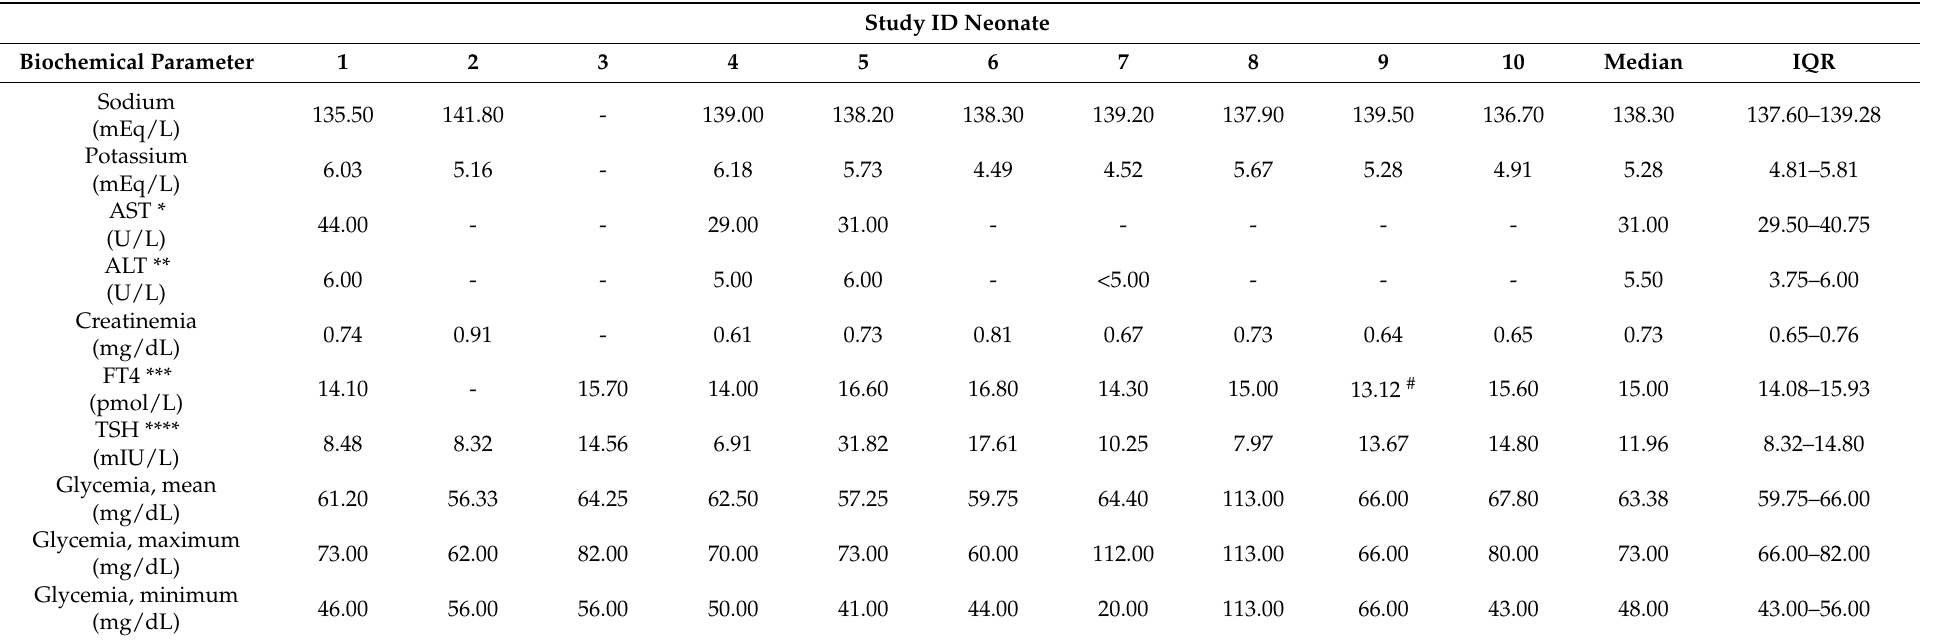
Table 4. Biochemical (blood) data on postnatal age day 1, of the included